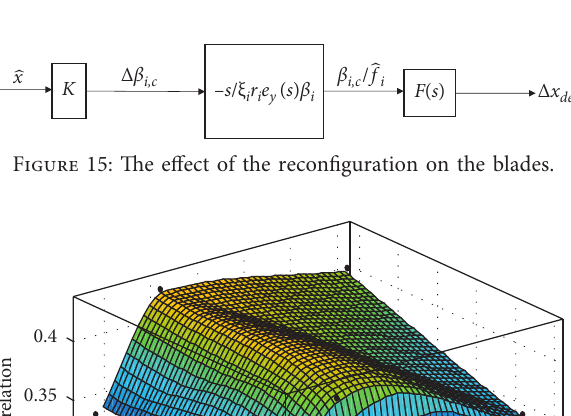
Figure 14: The bade deflections in the faulty deflections, nominal deflections, and fault tolerant deflections.